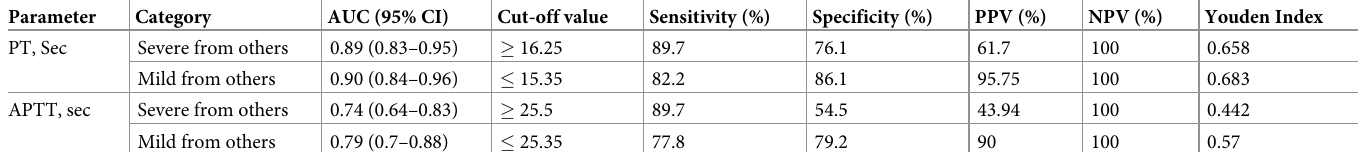
Table 4. The risk stratification values of baseline PT and APTT among COVID-19 patients attending at the Tibebe Ghion Specialized Hospital, COVID-19 treat- ment center 2021 (n = 117).